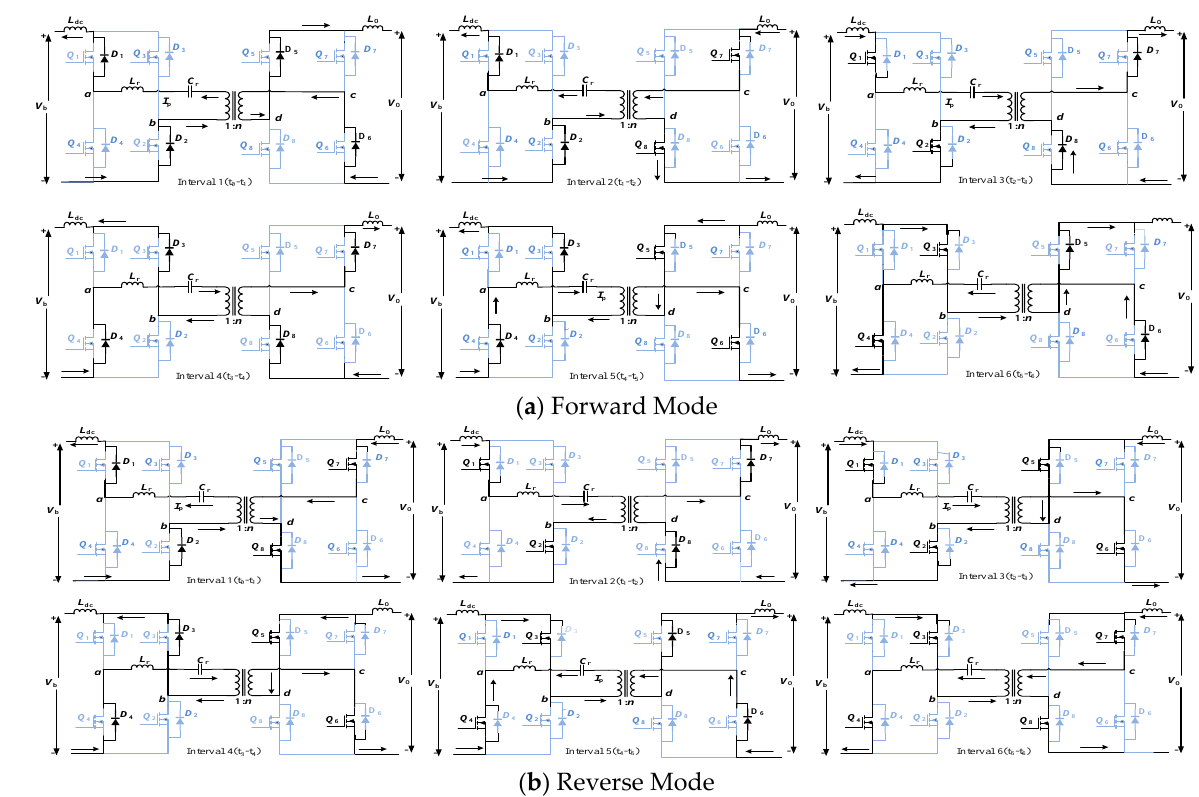
( b ) Reverse Mode Figure 4. Modes of operation. Figure 4. Modes of